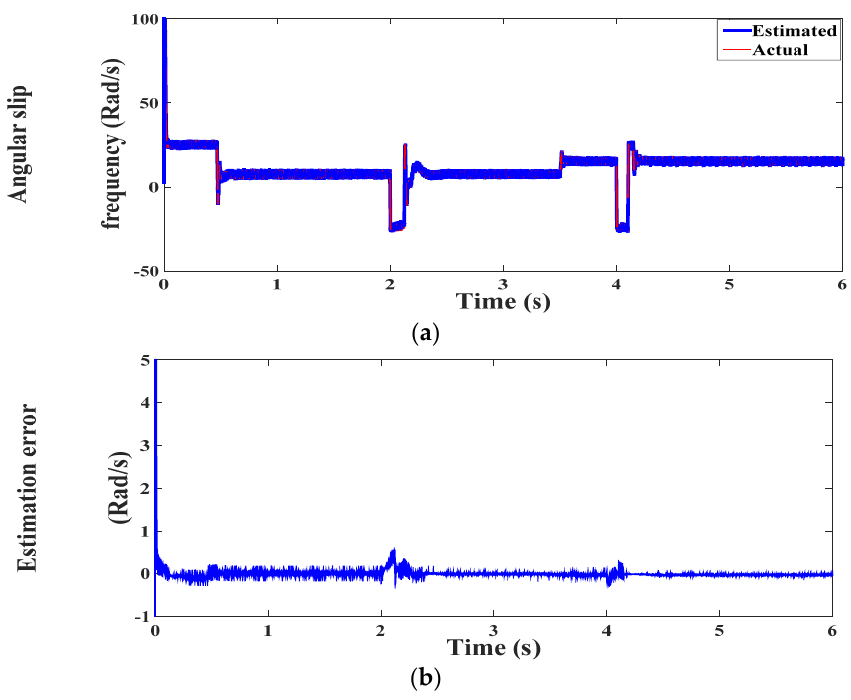
Figure 22. ( a ) Estimated and actual slip frequency. ( b ) estimation error.